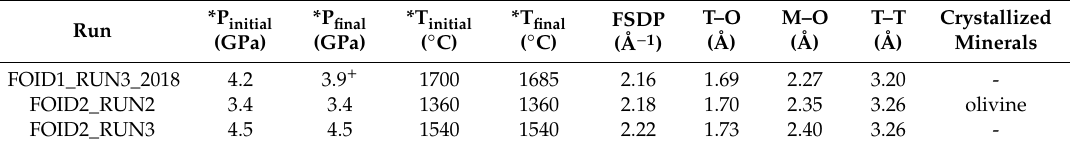
Table 3. Experimental conditions of melt structure measurements.